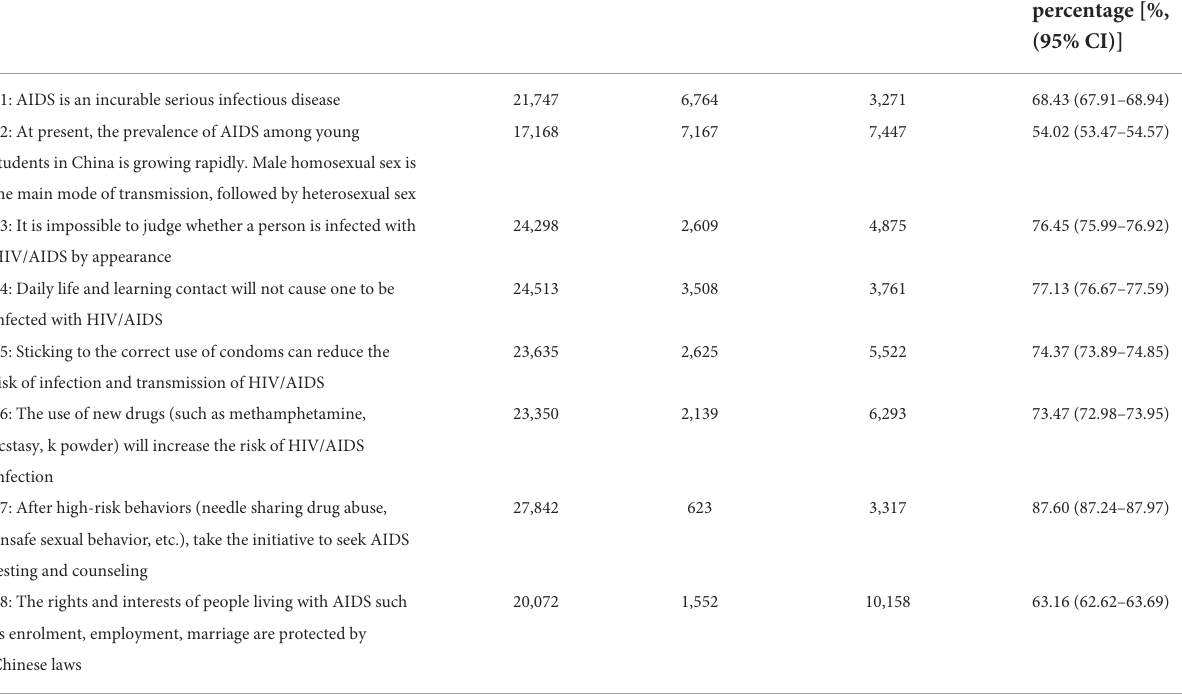
TABLE 2 Young students’ awareness of HIV/AIDS knowledge ( n =